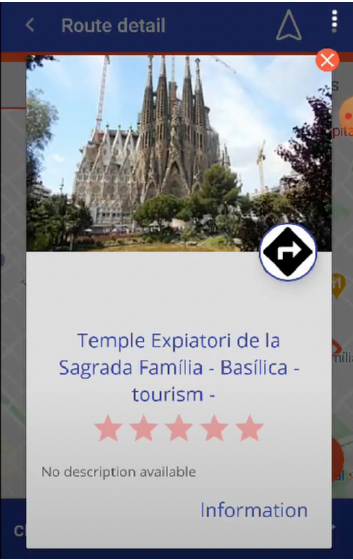
Figure 8. Detailed information about a suggested point of